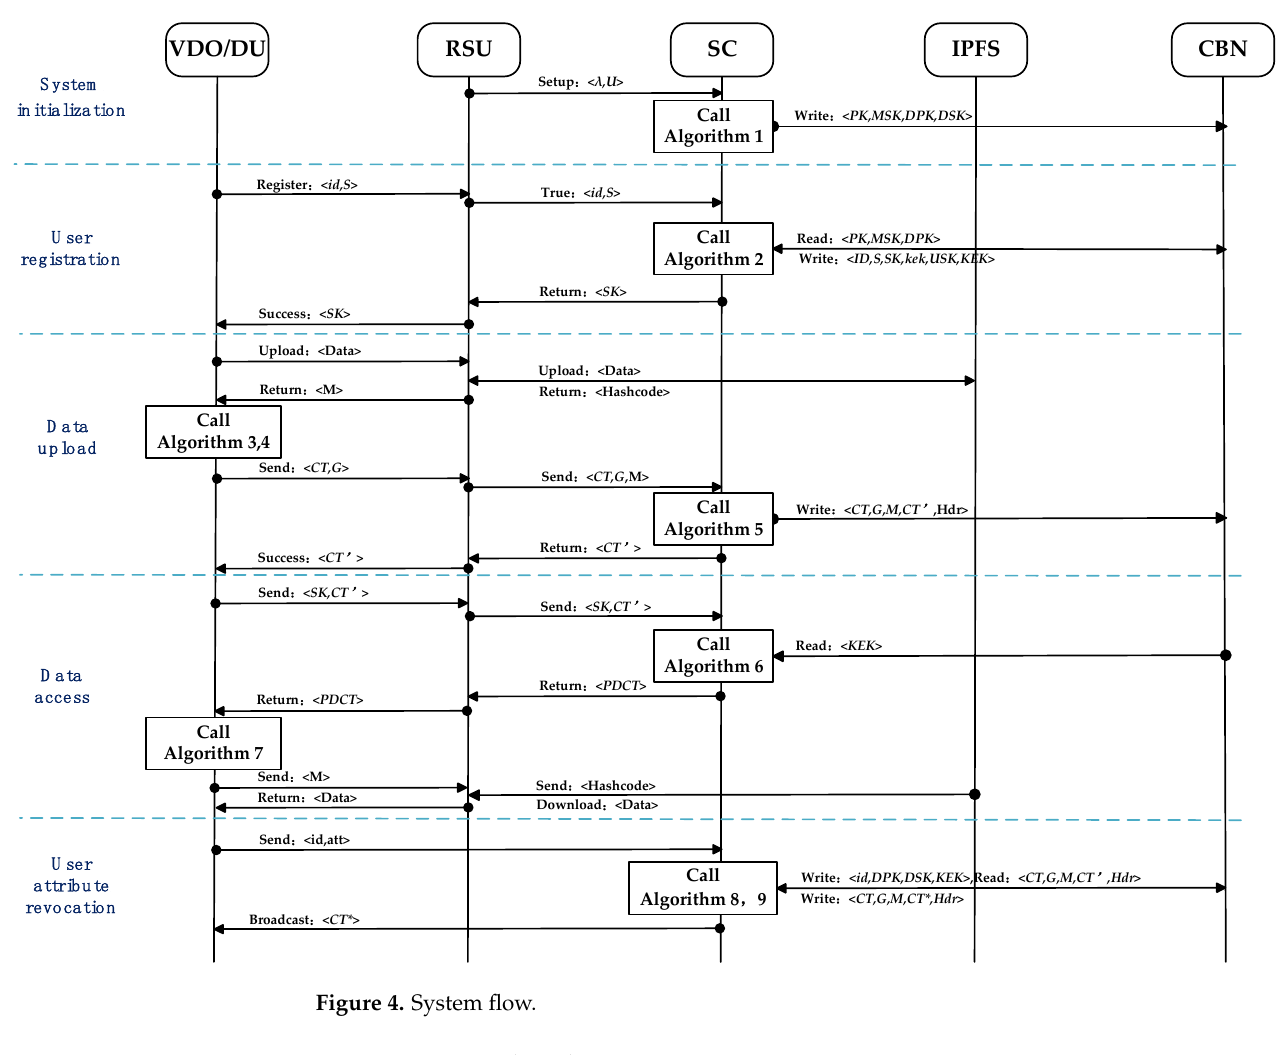
Figure 4. System